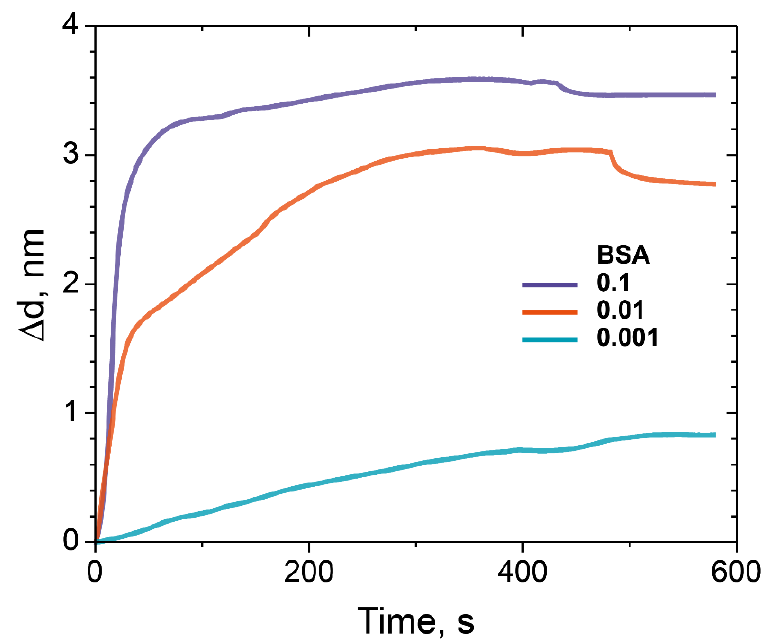
Figure 8. The change in the adlayer thickness upon the binding of BSA with different concentrations on ED-modified PC chip surface (Mw 500 kDa): 0.1 mg/mL (purple), 0.01 mg/mL (red), and 0.001 mg/mL (blue).